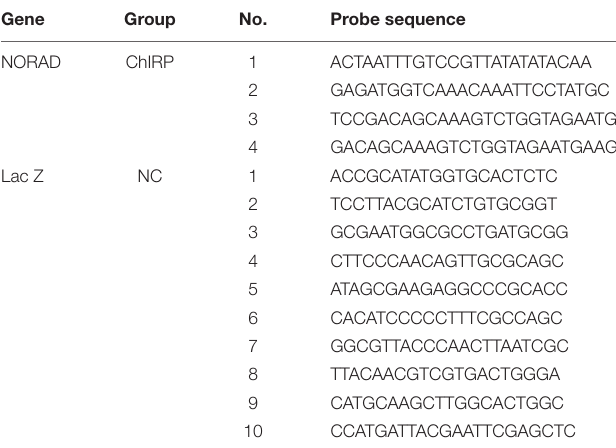
TABLE 2 | Probes used for